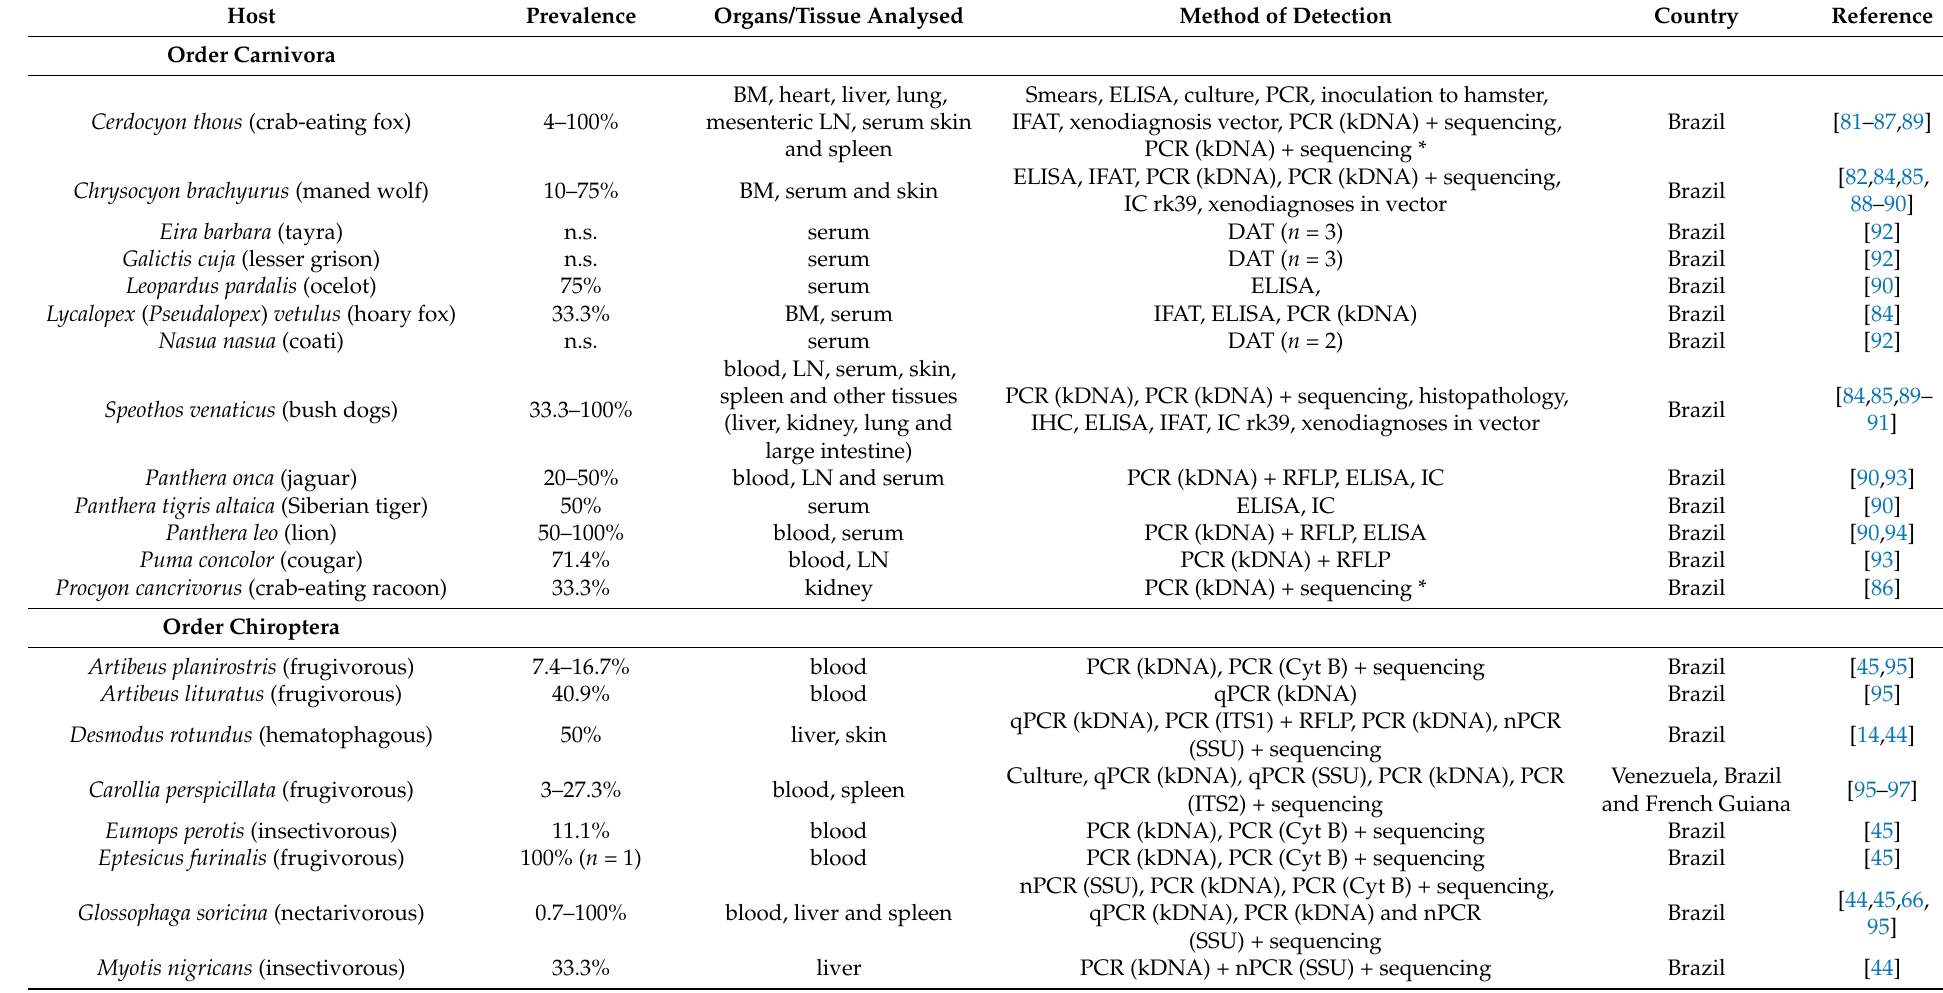
Table 5. Wild animals infected with L. infantum (sin. L. chagasi ) and Leishmania spp. in the Americas. Organs or tissues positive to the parasite, as well as techniques employed, are